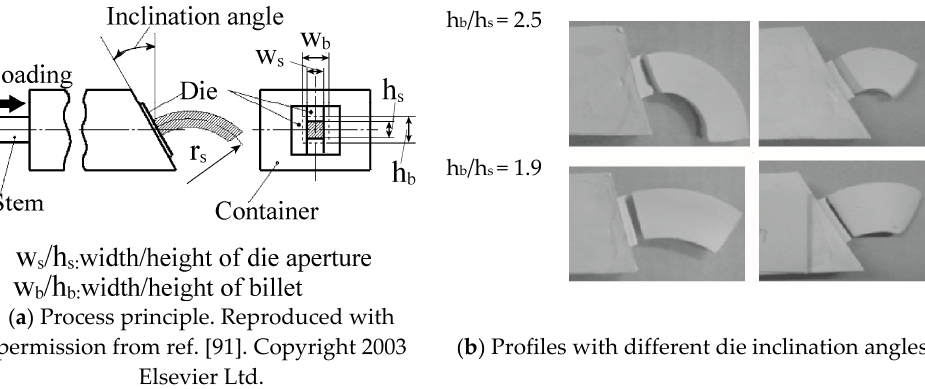
Figure 24. Design of the inclined extrusion die to achieve curved profiles [91,92].